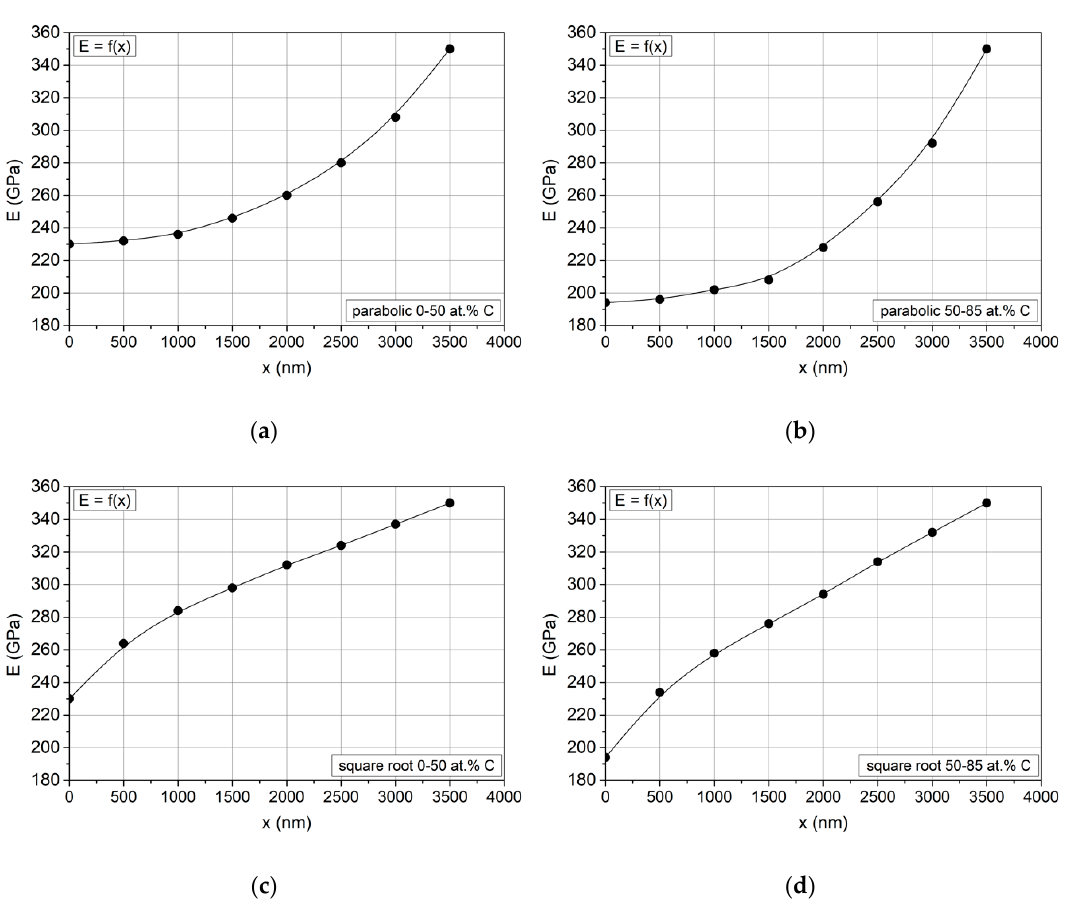
Figure 13. Profiles of changes in Young’s modulus values in Zr–C coatings, determined based on the carbon content profile and mixtures rule (Formula (2)). ( a ) Parabolic carbon content profile in the range of 0–50 at.%, ( b ) parabolic carbon content profile in the range of 50 to 85 at.%, ( c ) square root carbon content profile in the range of 0–50 at.%, ( d ) square root carbon content profile in the range of 50 to 85 at.%.